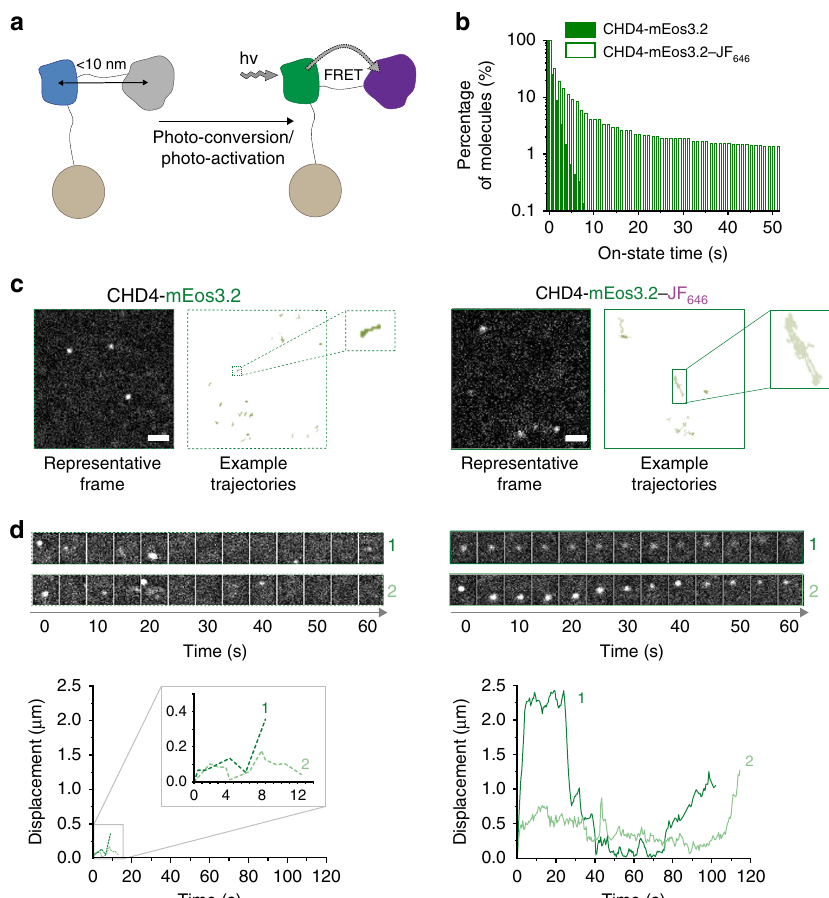
Fig. 3 FRET-enhanced mEos3.2 improves tracking of single CHD4 proteins. a Schematic illustrating an experiment where the chromatin remodeler CHD4, a component of the NuRD complex, was fused with a C-terminal mEos3.2-HaloTag in mouse ES cells. b Histograms showing the percentage of molecules with a particular on-state time (i.e., individual track length) remaining after photo-conversion when performing sptPALM of either mEos3.2 ( fi lled bars) or the mEos3.2 – JF 646 FRET pair (open bars) under identical imaging conditions. c Representative 500 ms exposure images from the middle of the nucleus (left) and representative trajectories (right) are shown for mEos3.2- and mEos3.2 – JF 646 -tagged single CHD4 molecules (scale bar = 1 µ m). d Montages (generated for every 10 frames collected) and plots of the distance moved from their point of photo-conversion, for two mEos3.2- and two mEos3.2 – JF 646 - tagged CHD4